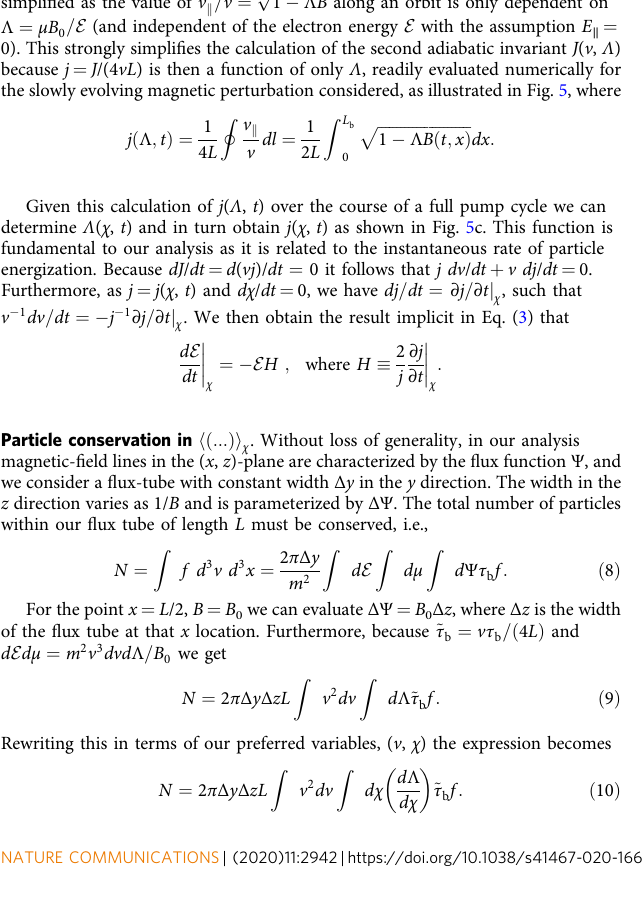
Fig. 5 j as a function of invariants. a Plot of the maximum magnetic- fi eld amplitude over the course of a fl uctuation for a maximum magnetic fi eld of δ B / B = 0.5. b Plot of j as a function of Λ over the course of a fl uctuation for 0 the magnetic fi eld in a . c Plot of j ( χ , t ) normalized by j ( χ , t 0 ) for the same fl uctuation. d Plot of j ( χ , t 0